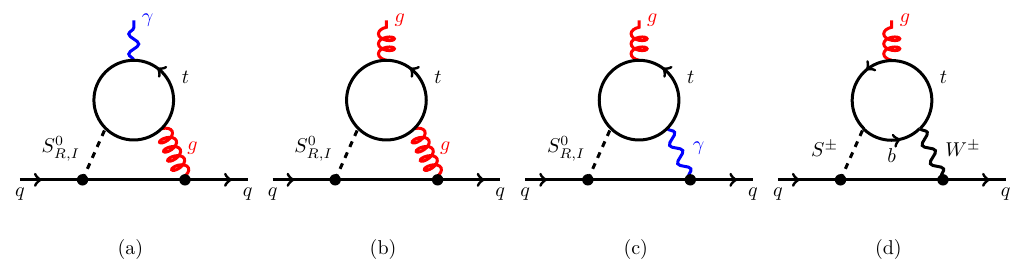
Figure 4 . Barr-Zee type diagrams contributing to the CEDM (diagram (a)) and to the EDM (diagrams (b)) in the MW